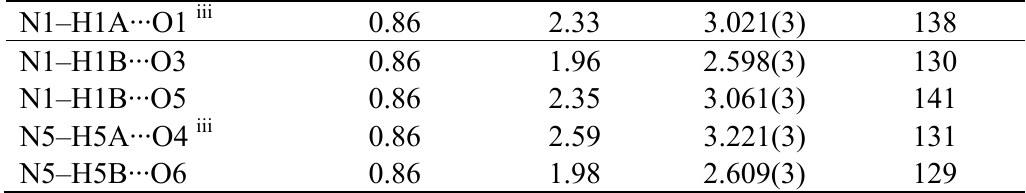
Table 2. Hydrogen-Bond geometries for 1